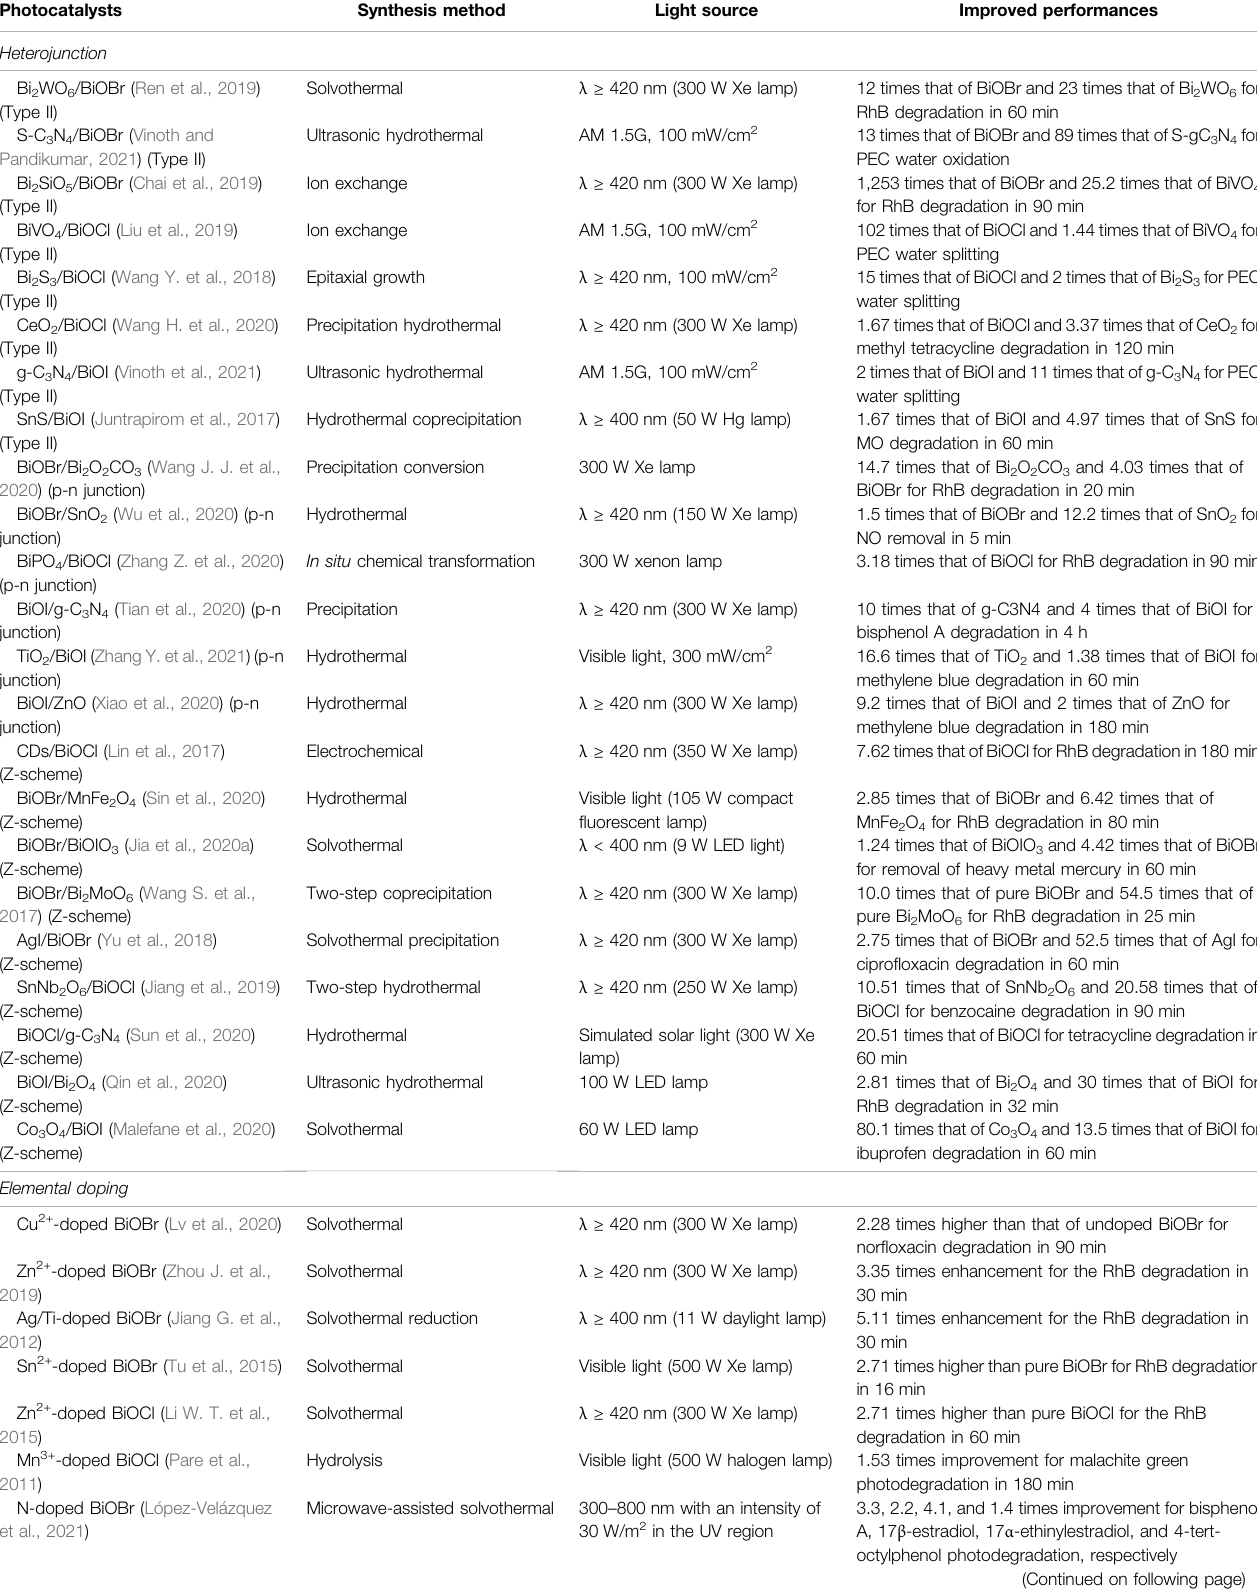
TABLE 1 | Summary of BiOX-based composites with improved photocatalytic